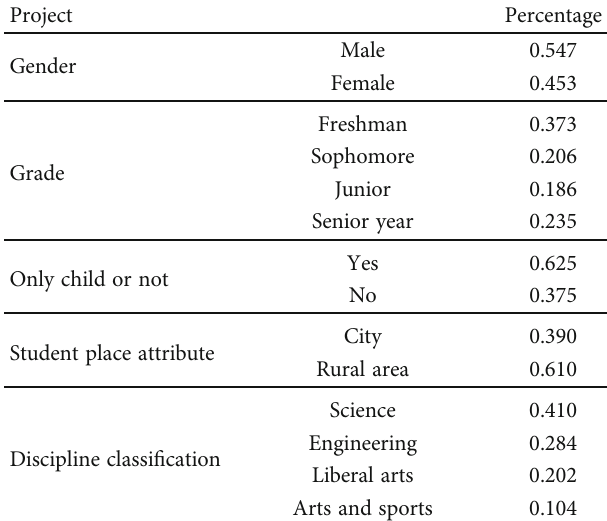
Table 1: Basic information description chart of